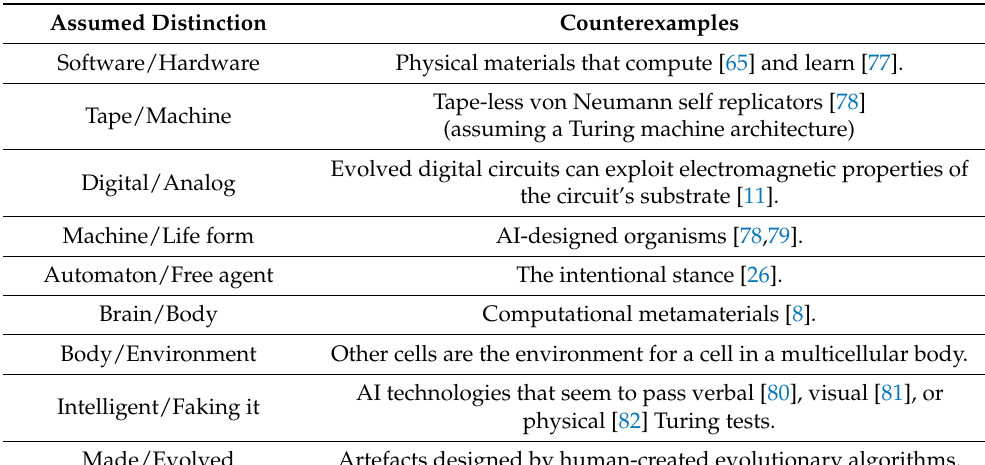
Table 1. Some common assumed distinctions in biology and technology, and recent advances that serve as counterexamples, suggesting a spectrum of